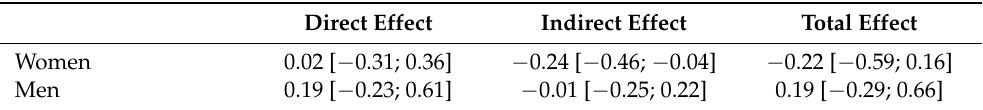
Table 3. Direct, indirect, and total effects in mediation models for women and men with unstandard- ized coefficient estimates and 95% confidence